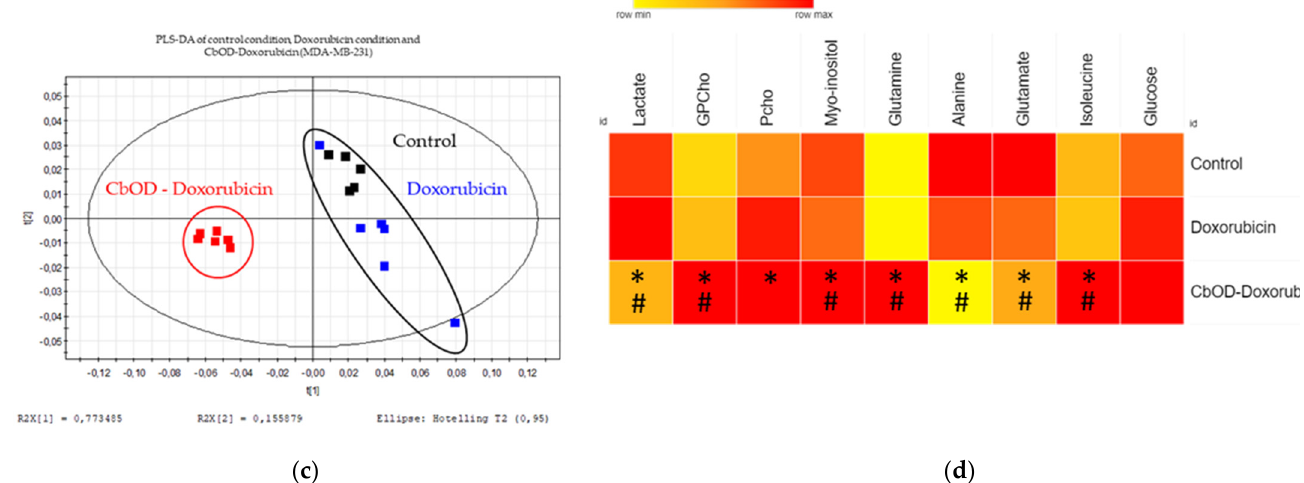
Figure 6. Impact on MDA-MB-231 metabolism. ( a ) The 600-MHz 1 H-NMR spectra of the intracellular polar extract of cells treated with CbOD-Doxorubicin, with Doxorubicin and the control cells showing a metabolite variation with a VIP ≥ 1. ( b ) Scores plot (PCA) of the intracellular spectra of the samples from the control cells (black), Doxorubicin-treated cells (blue) and CbOD/Doxorubicin-treated cells (red) in 234 variables. ( c ) Scores plot (PLS-DA) of the intracellular spectra of samples from the control cells (black), Doxorubicin-treated cells (blue) and CbOD/Doxorubicin-treated cells (red) in 234 variables. ( d ) Heatmaps of the discriminant metabolites identified between the 3 conditions. n = 6 and significance: * p < 0.05 for CbOD-Doxorubicin in comparison to the control; # p < 0.05 for CbOD-Doxorubicin in comparison to Doxorubicin.